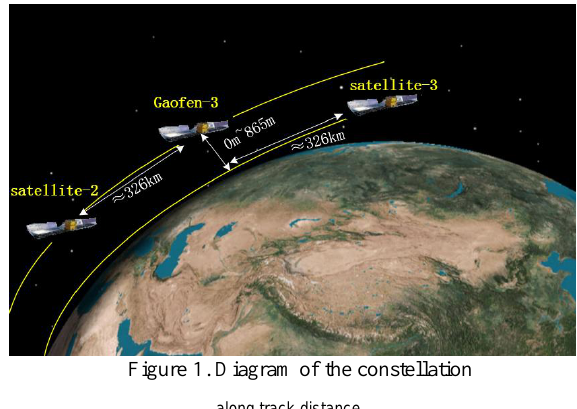
Figure 3. Stereo and InSAR working mode